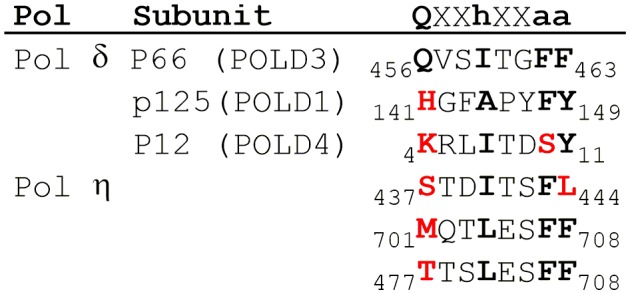
PCNA-binding domains of human pol δ and η.Sequence alignment of PCNA-interacting peptide (PIP) boxes from human pols δ (Bruning and Shamoo, 2004) and η (Masuda et al., 2015). The generic amino acid sequence of a canonical PCNA-interacting peptide (PIP) box is shown at the top where ‘X’ represents any amino acid, ‘h’ is a hydrophobic residue (usually L, I, or M), and ‘a’ is an aromatic residue (usually F or Y). The canonical PIP-box elements are shown in bold. Non-canonical PIP boxes contain deviations from the conserved residue (shown in bold red).